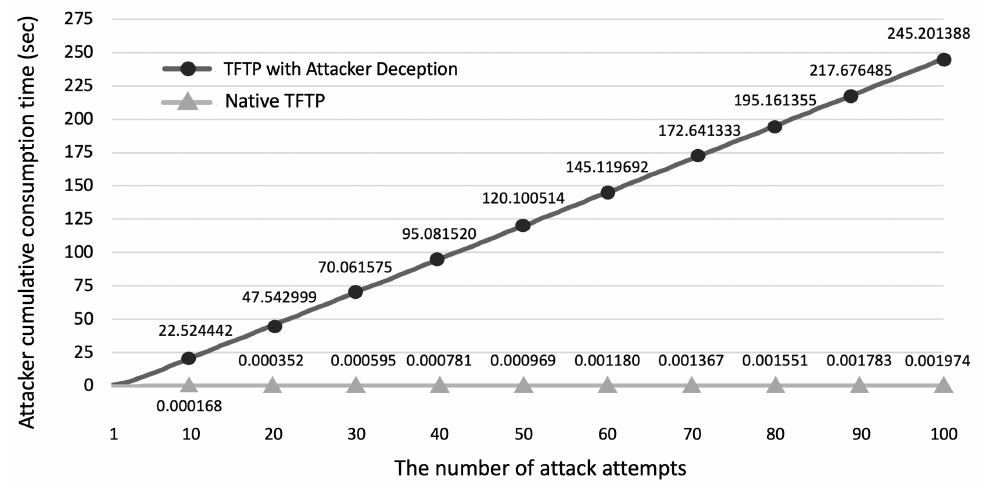
Figure 12. Attacker cumulative time consumption: native TFTP vs. TFTP with attacker